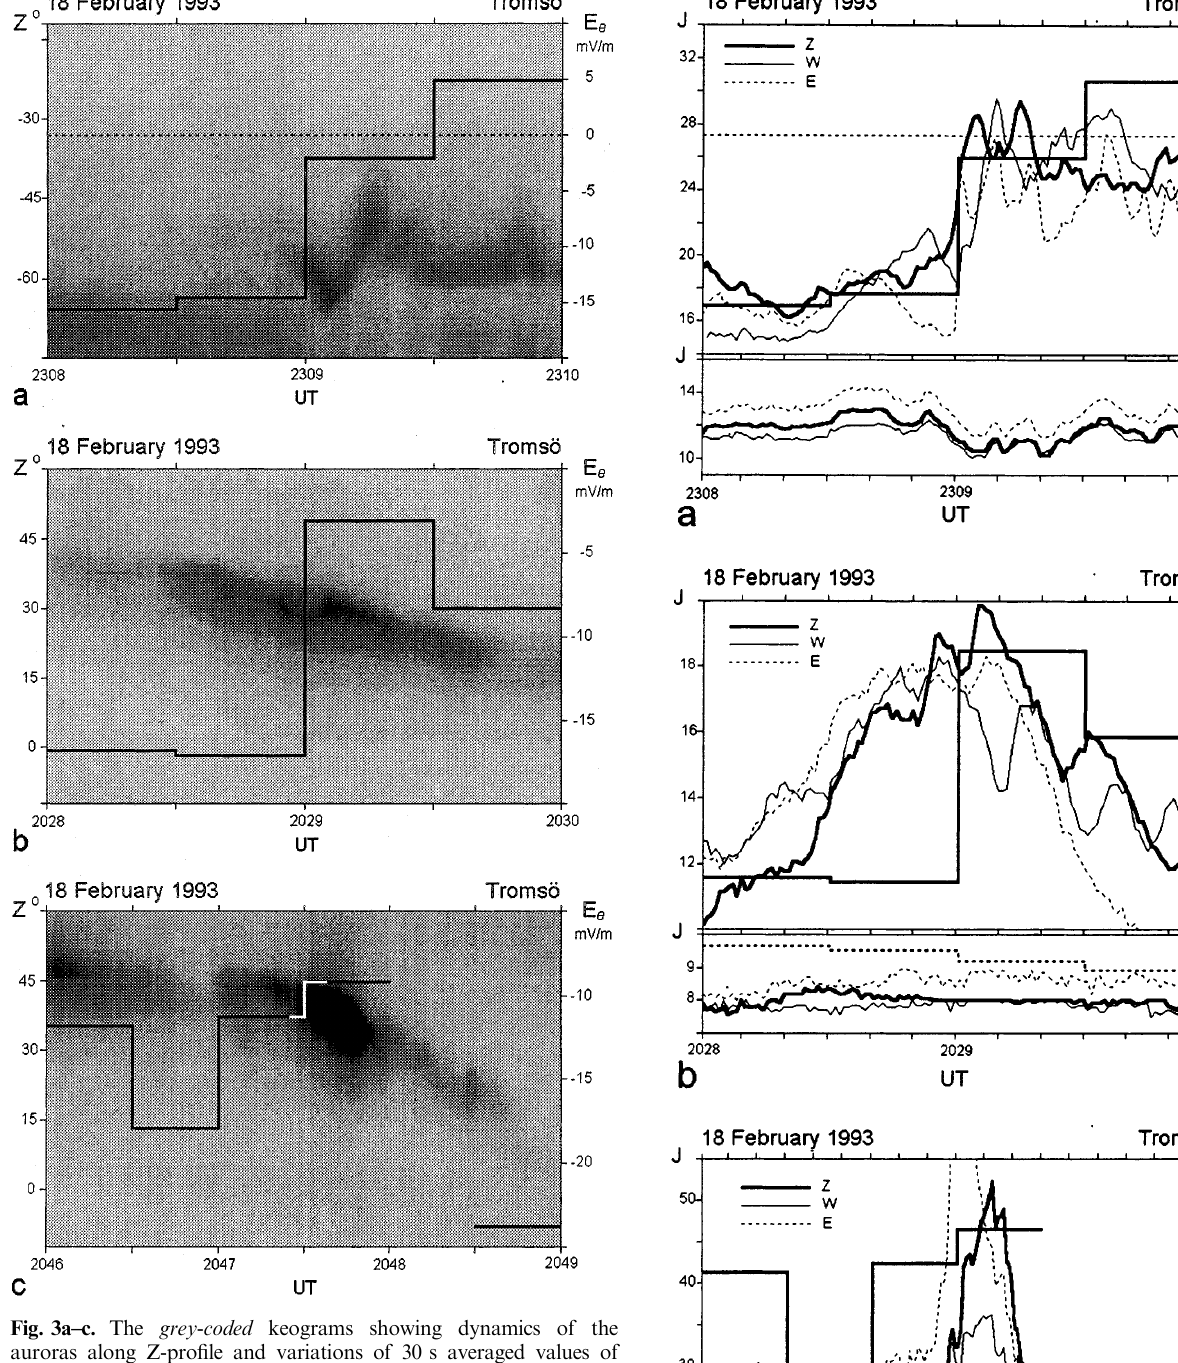
Fig. 4a–c. Three plots of simultaneous optical and EISCAT obser- vation. In each plot the upper panel shows the variations of the mean value of the arc luminosity and the lower panel shows the variations of the mean value of the sky luminosity ( curves ) and electron concentration in the ionospheric E-region ( dashed step-like traces ) in vicinity of the EISCAT zenith. As in Fig. 3, black step-like traces indicate the variations of the azimuthal electric field. J means the intensity of the luminosity (arbitrary units)